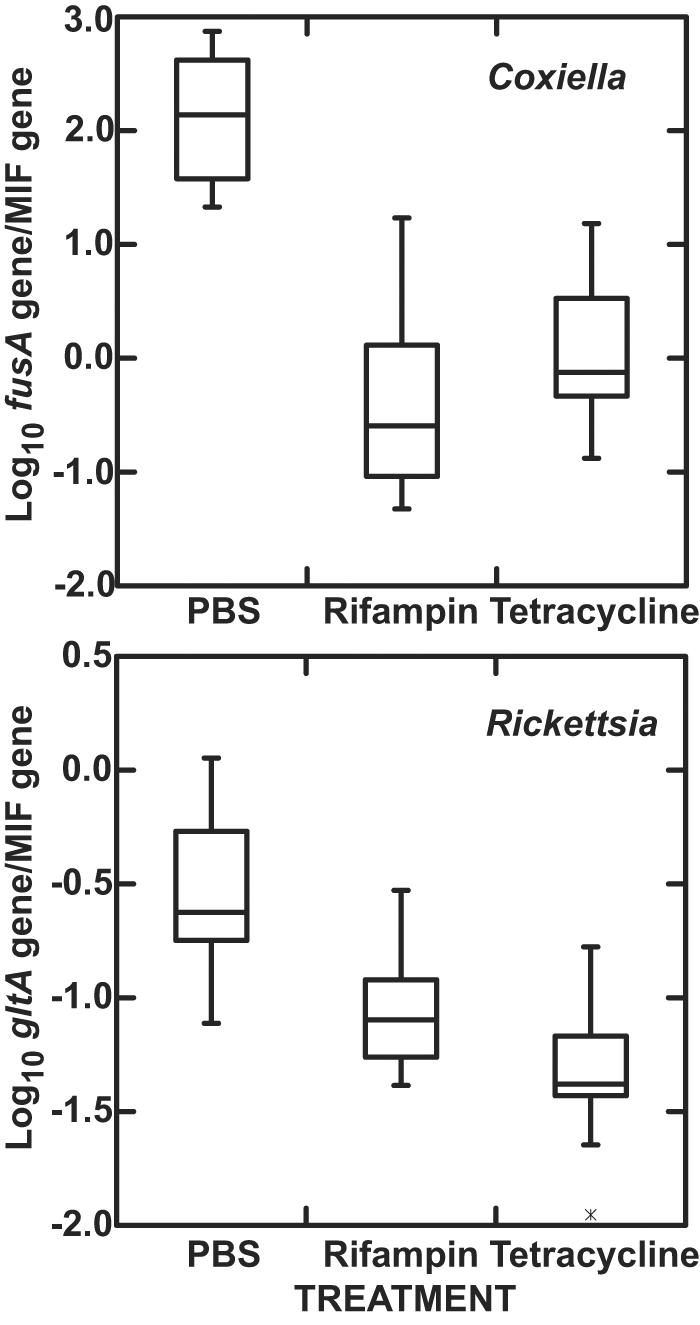
Box-and-whisker plots of log10 ratios of fusA gene of Coxiella sp. to MIF gene of A. americanum (upper panel) or log10 ratios of gltA gene of Rickettsia sp. to MIF gene (lower panel) in post-oviposition ticks that were treated by injection with single doses of PBS (n = 9), rifampin (n = 10), or tetracycline (n = 10) as fed, mated females.